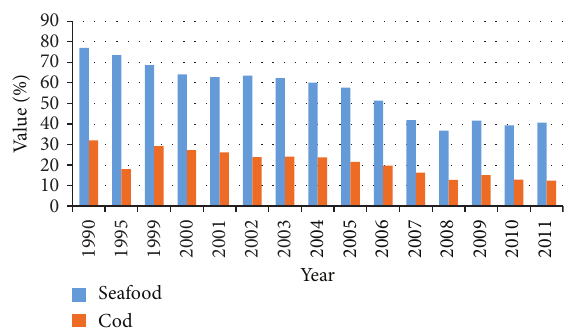
Figure 1: Ratio of seafood of total value of exports and ratio of cod in total value of seafood during